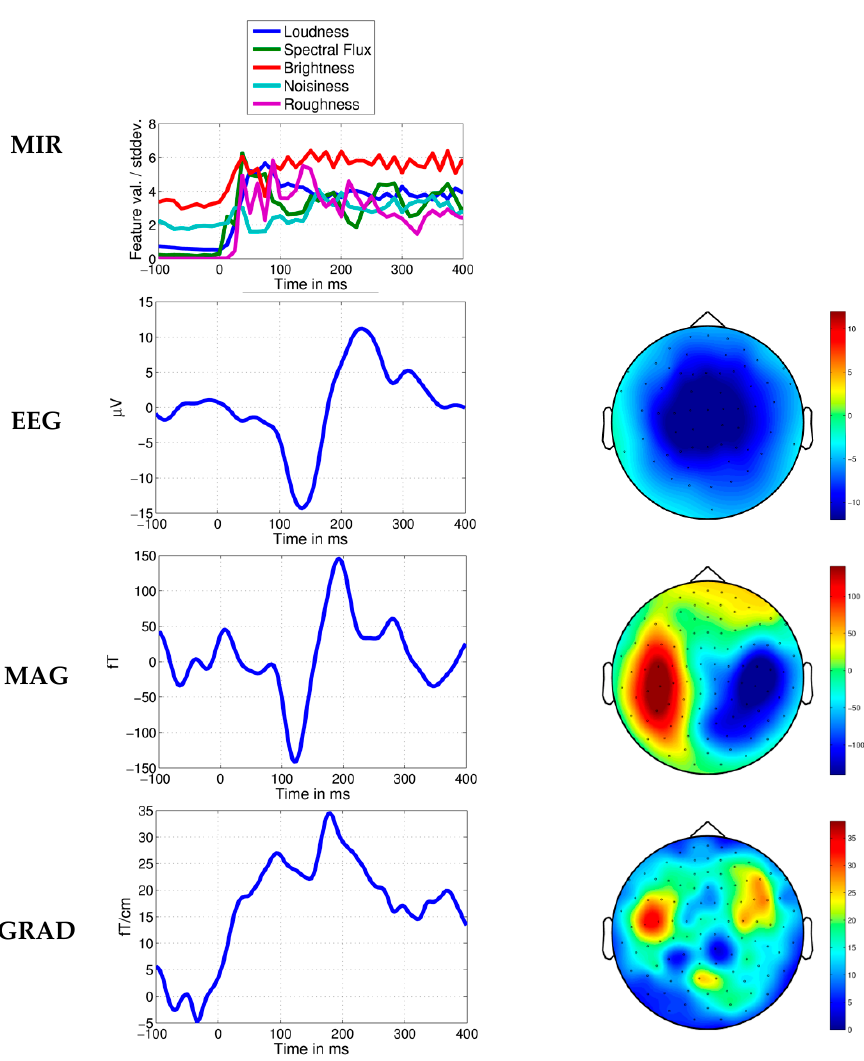
Figure 5. Response to novel loudness increase in Dream Theater’s Stream of Consciousness . Average MIR feature values per standard deviation, EEG, MEG axial magnetometer (MAG) and MEG planar gradiometer (GRAD) waveforms shown 100 ms before and 400 ms after the time point at 20.316 s. Topographies in relation to the head are shown for the negative N1-like brain response measured in a time window of ±15 ms around the peak. In the MEG topographies it can be seen that the brain response is strongest in sensors located approximately above brain regions involved in sound processing.